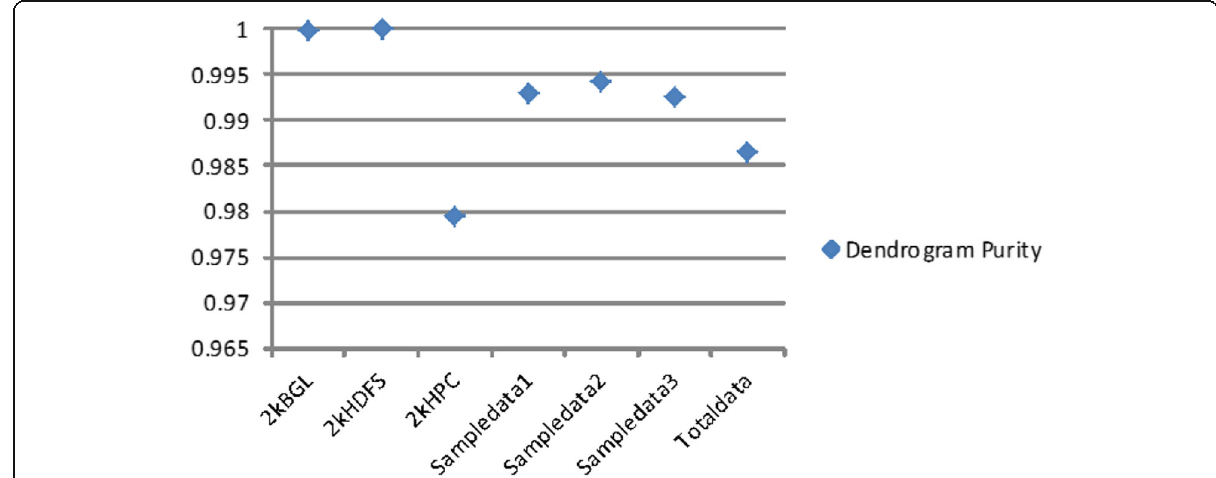
Fig. 9 Comparison of the dendrogram purity of the LogOHC on different data